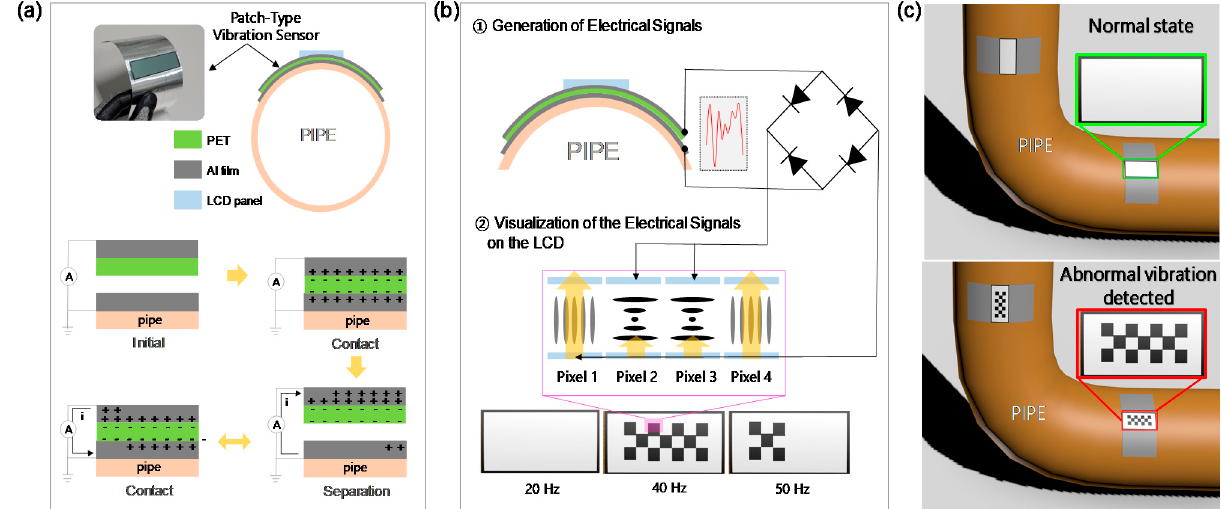
Figure 1. Schematic illustration and working mechanism of ( a ) the PVV sensor probe and ( b ) the visualization system. ( c ) Example of the PVV sensor system for detecting abnormal vibration signals on a coolant pipe.